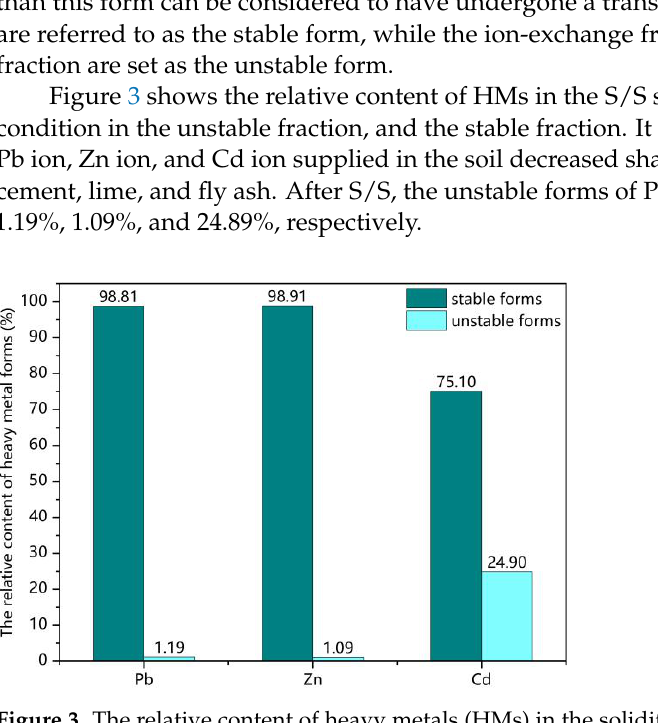
Figure 4. The variation of the relative content of HM forms with F – T cycles in the S/S Pb-Zn-Cd composite HM-contaminated soil. (a) unstable HM forms; (b) stable HM forms. The variation of the relative content of stable fractions of three HMs in S/S soil with the number of F – T cycles is shown in Figure 5. It can be seen that the relative content of the carbonate-bound fraction of HMs decreases significantly with F – T cycles. The effect is significant within the 14 F – T cycles, the slope of the curve is large, and the rate of decline is fast. However, with the increase of the F – T cycles times, the rate of decline of carbonate- bound forms becomes relatively slow. After 14 F – T cycles, the relative contents of